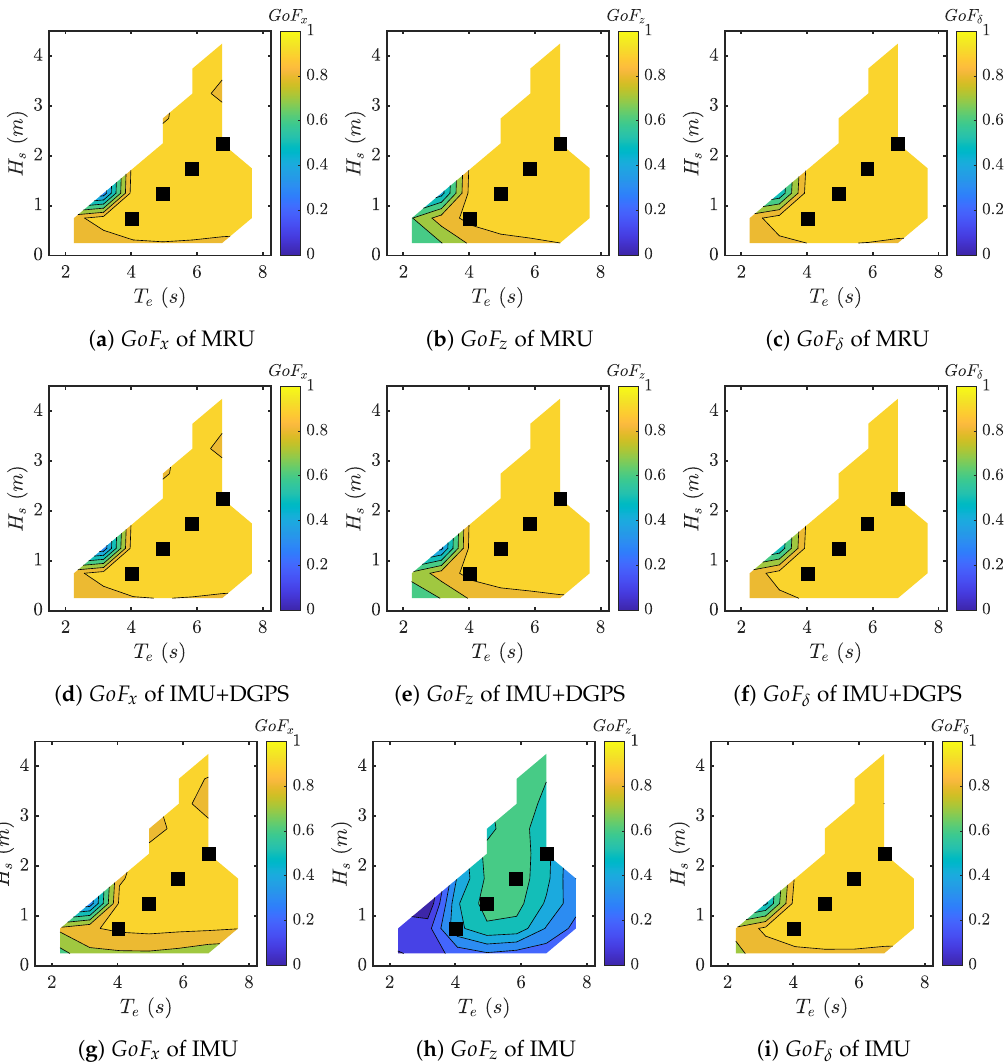
Figure A2. GoF results with noisless measurements for each measurement framework obtained with the NN. The first row refers to the MRU framework ( a – c ), the second to the IMU+DGPS framework ( d – f ), the thrid to the IMU framework ( b – i